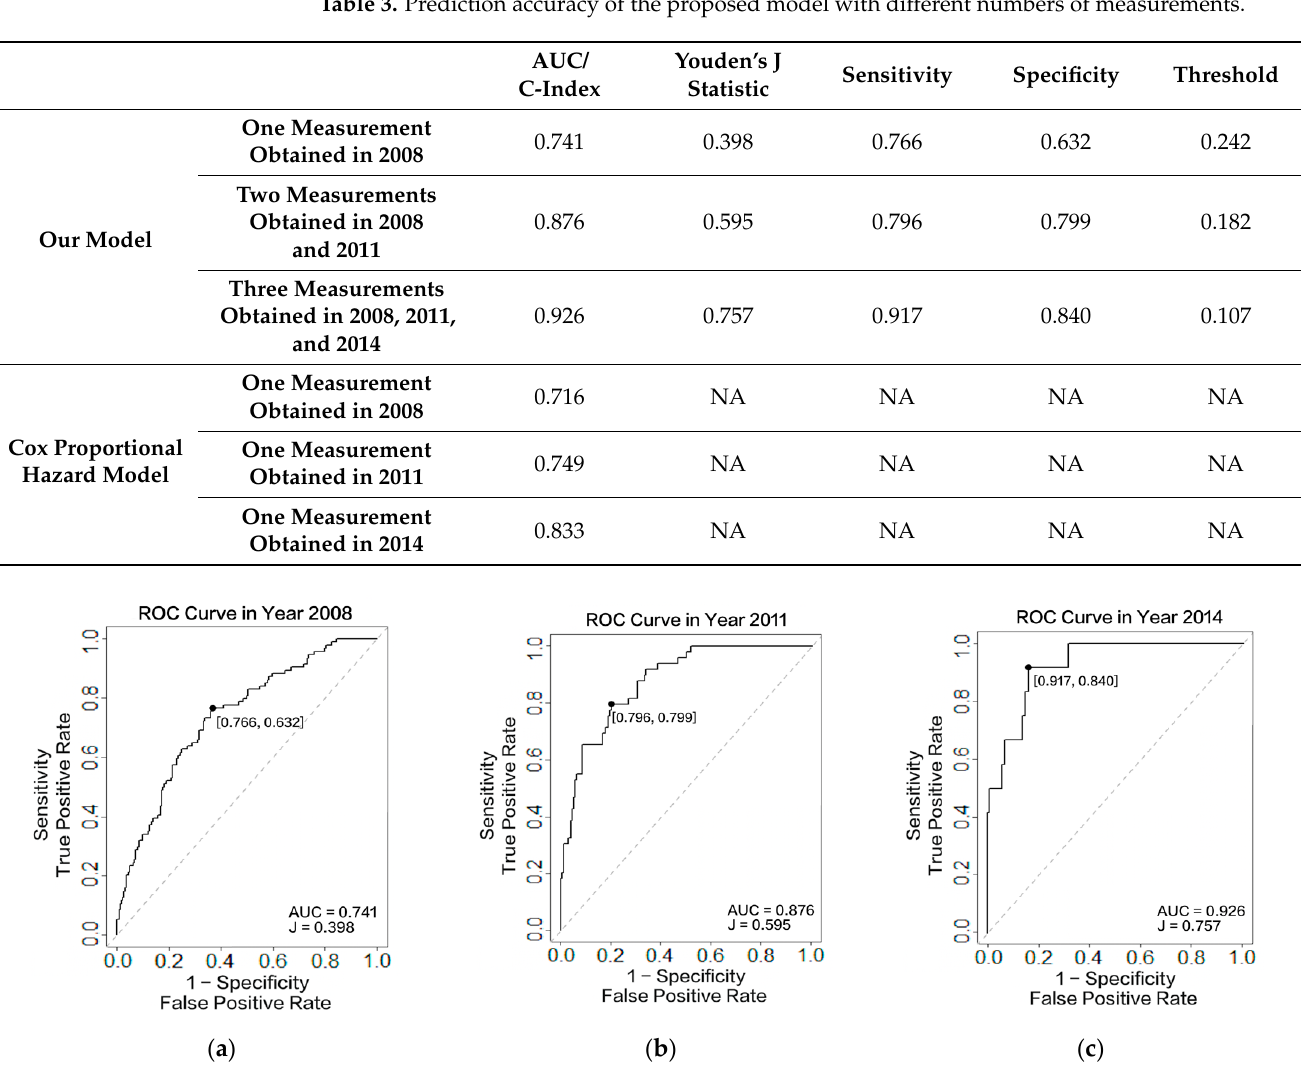
Figure 2. Receiver operating characteristic (ROC) curves for dynamic prediction, with incremental number of measurements. The x -axis is the false positive rate, calculated as (1 – specificity) and the y -axis is the true positive rate, calculated as sensitivity. Black dots indicate the optimal threshold of ROC curve, with sensitivity and specificity in the bracket. ( a ) ROC curve with one measurement (2008) in 2008; ( b ) ROC curve with two measurements (2008, 2011) in 2011; and ( c ) ROC curve with three measurements (2008, 2011, and 2014) in 2014.